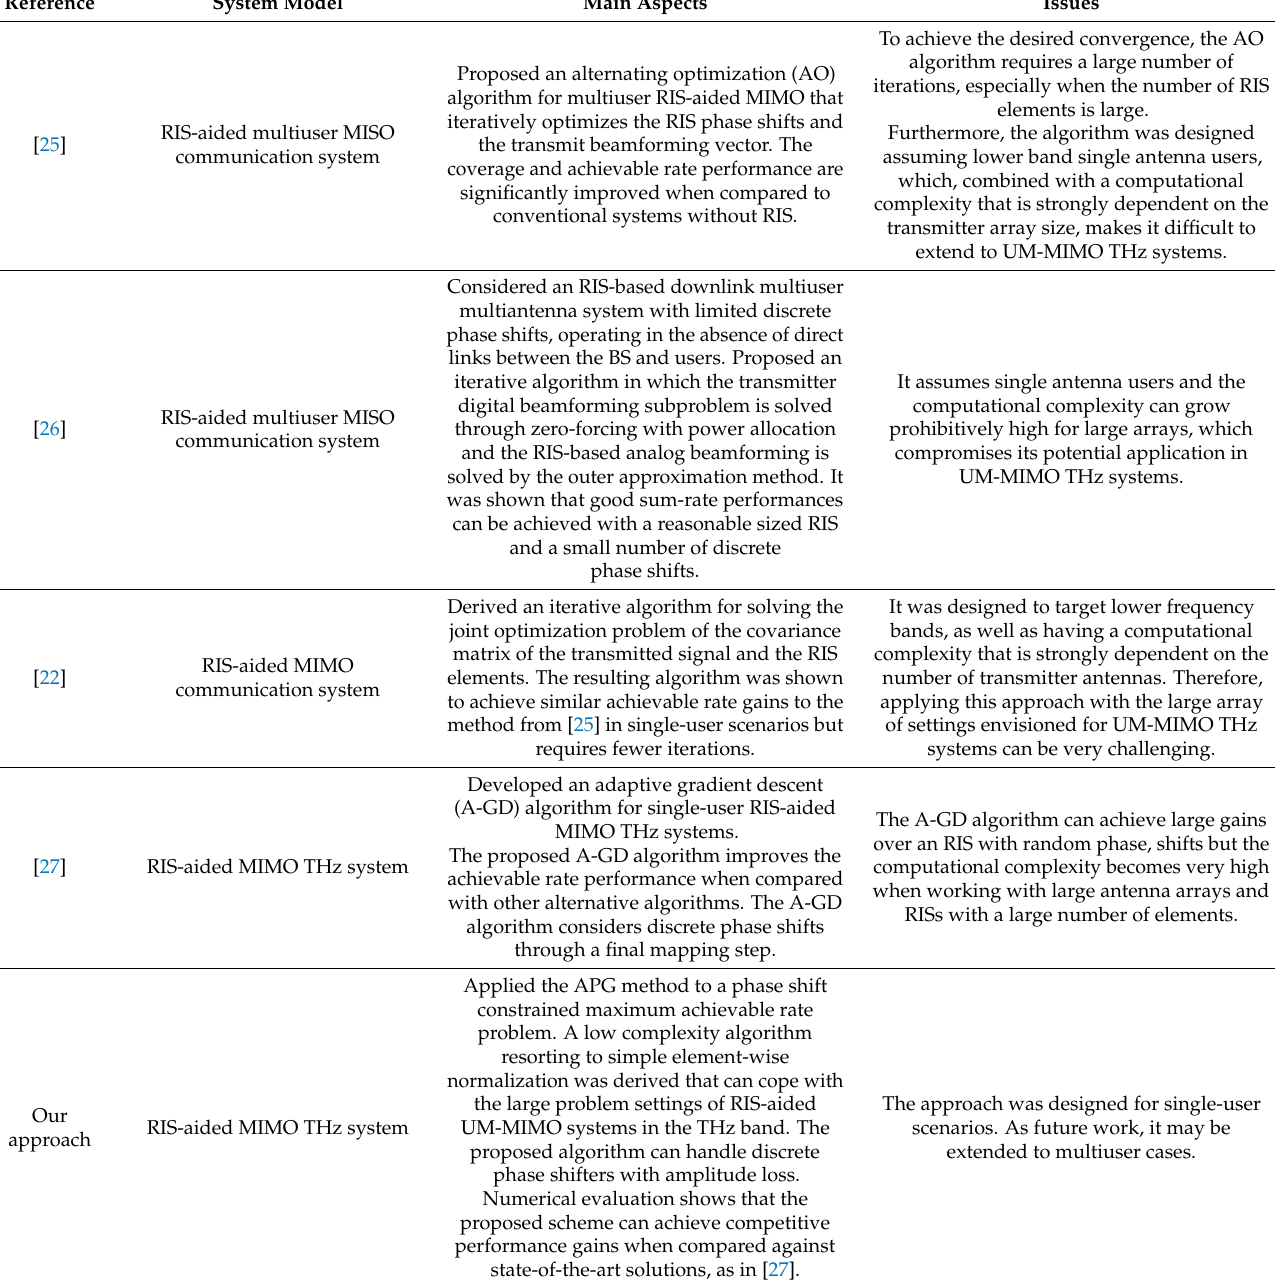
Table 1. Relevant works on the topic from the